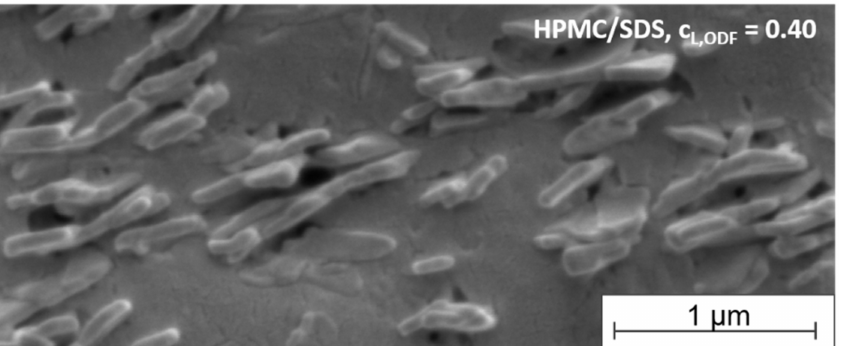
Figure 6. SEM image of the cross-section of an ODF loaded with tristearin particles (lipid content 0.40) formulated with